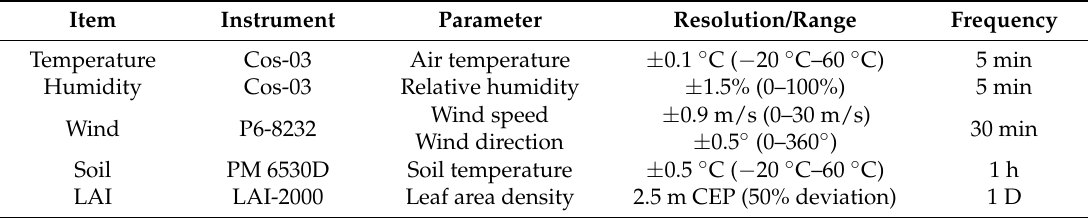
Table 1. Parameters and instruments used during the field measurements. LAI: leaf area index.